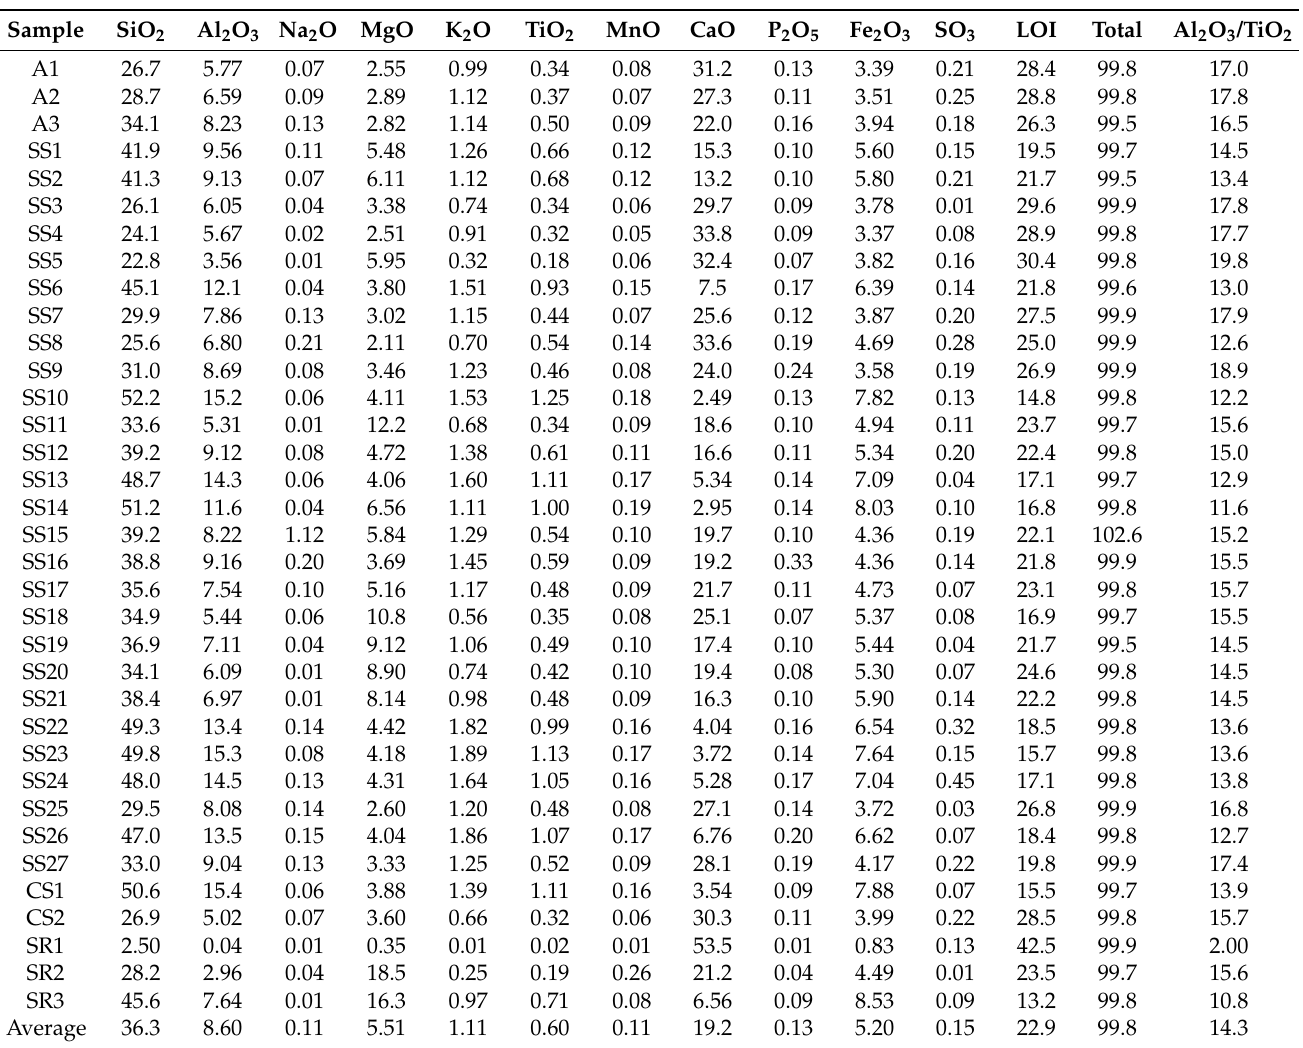
Table 4. Major oxides (wt.%) concentrations of the soils and source rocks in the study area.